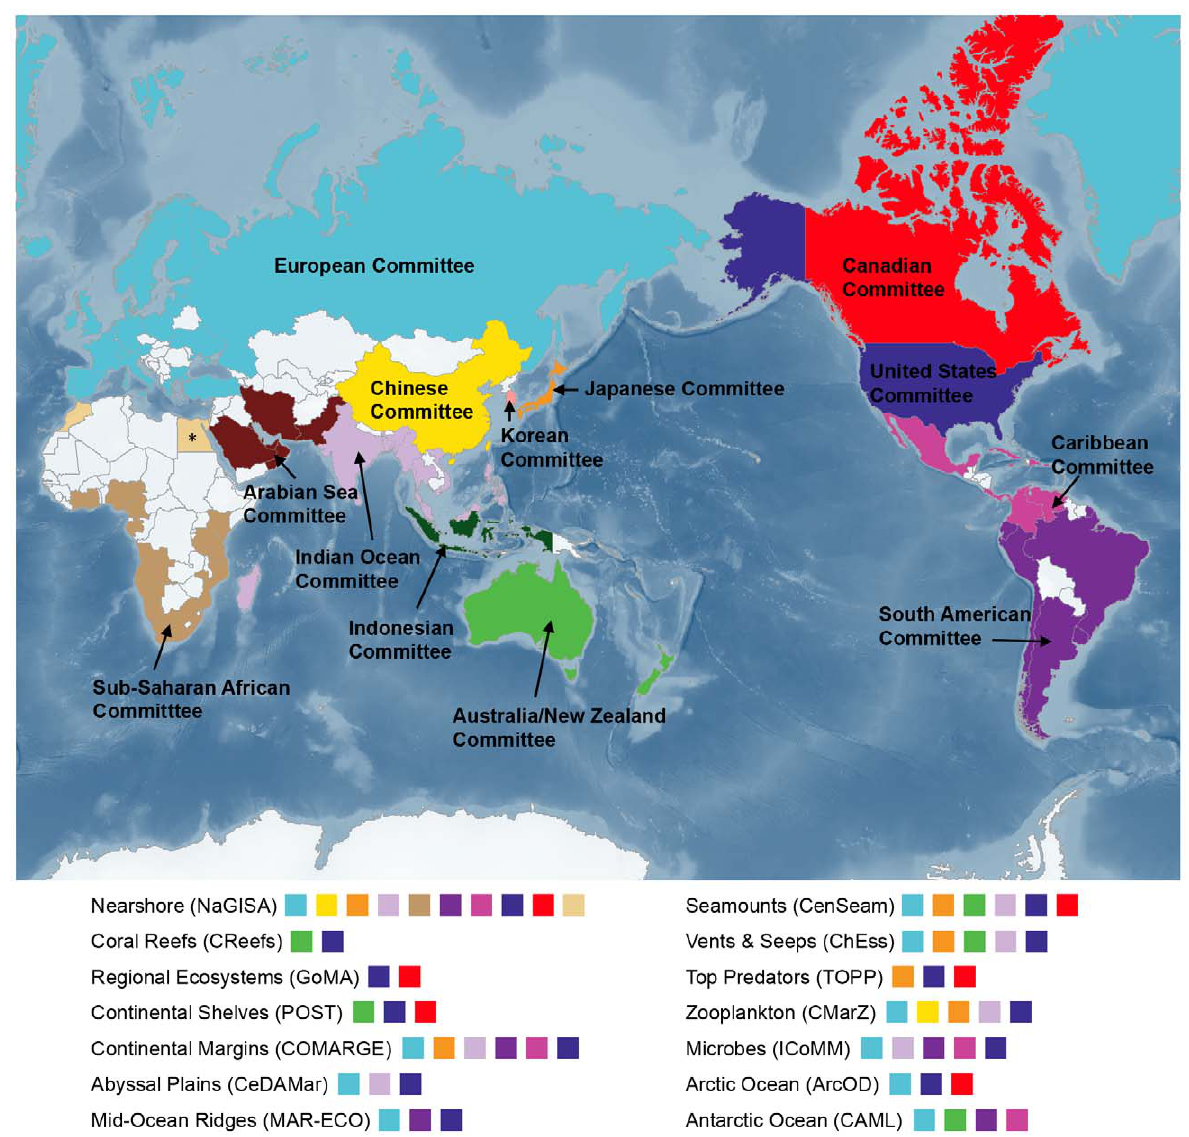
Figure 2. Countries encompassed by the NRICs from 2001 to 2010 and their field project interactions. This map, with each NRIC indicated in a different color, shows the countries encompassed by each NRIC. Below, the same colors indicate which NRICs played major roles in globalization of Census field projects. The success of NaGISA as an ‘‘ambassador’’ project is evident as almost all NRICs participated. All NRICs had strong involvement in the Ocean Biogeographic Information System, but some (Korea, Indonesia, Arabian Sea) focused solely on data assembly. (* Morocco and Egypt participated in the Census outside of NRIC auspices.) See www.coml.org for further details on the projects and acronyms.